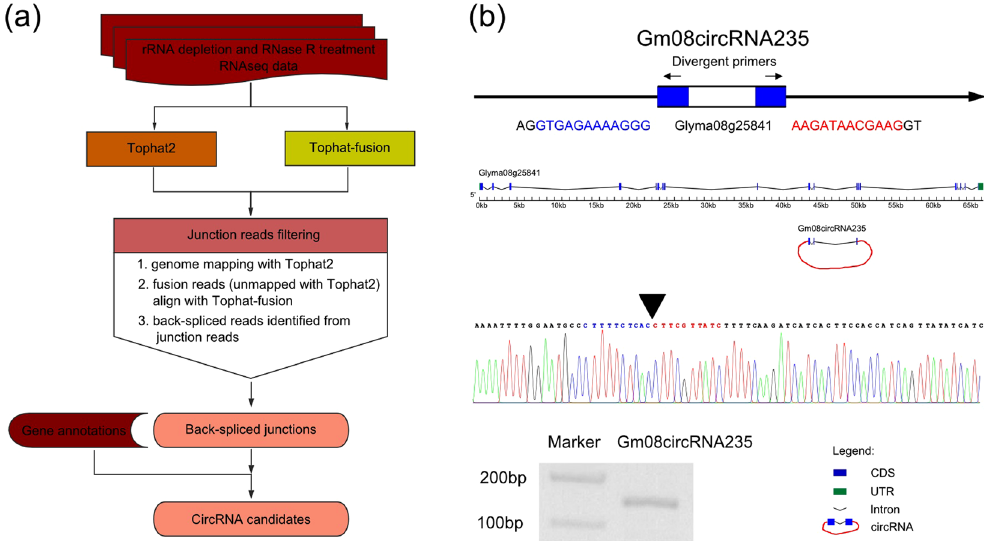
Figure 1. Pipline and validation method used for identification of circRNAs in soybean. ( a ) Pipline used for identification of circRNAs in soybean. All the steps were displayed in the form of the flowchart. ( b ) An example of validation strategy of circRNA. The upper part represented how the divergent primers were designed for PCR. In the middle, the parental gene structure and length scale were showed. Next part was the circRNA with back-spliced junction displayed by red trace line. The lower parts were the results of Sanger sequencing and agarose gel electrophoresis. The agarose gel electrophoresis image showed the expected size of PCR product, and Sanger sequencing were performed to confirm head-to-tail back-spliced site (black arrow). The flanking sequences of back-spliced site were marked by blue and red.